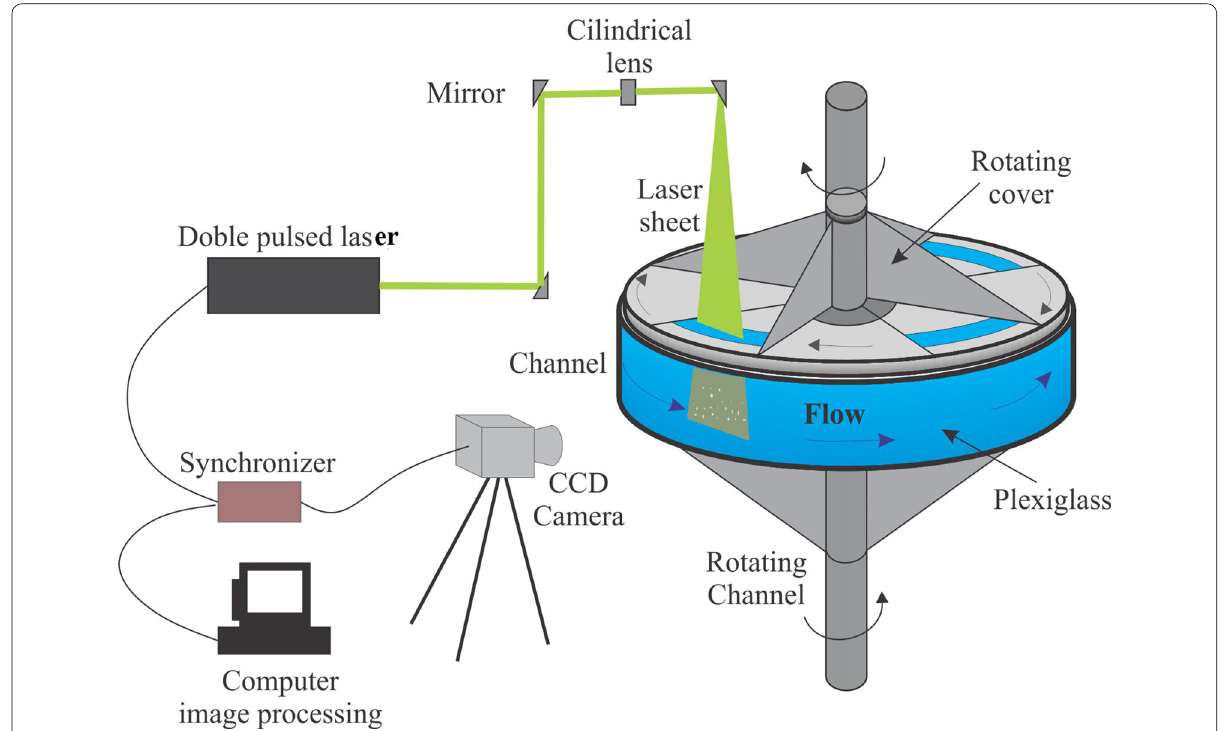
Fig. 2 Rotating annular flume (RAF) and PTV set‑up